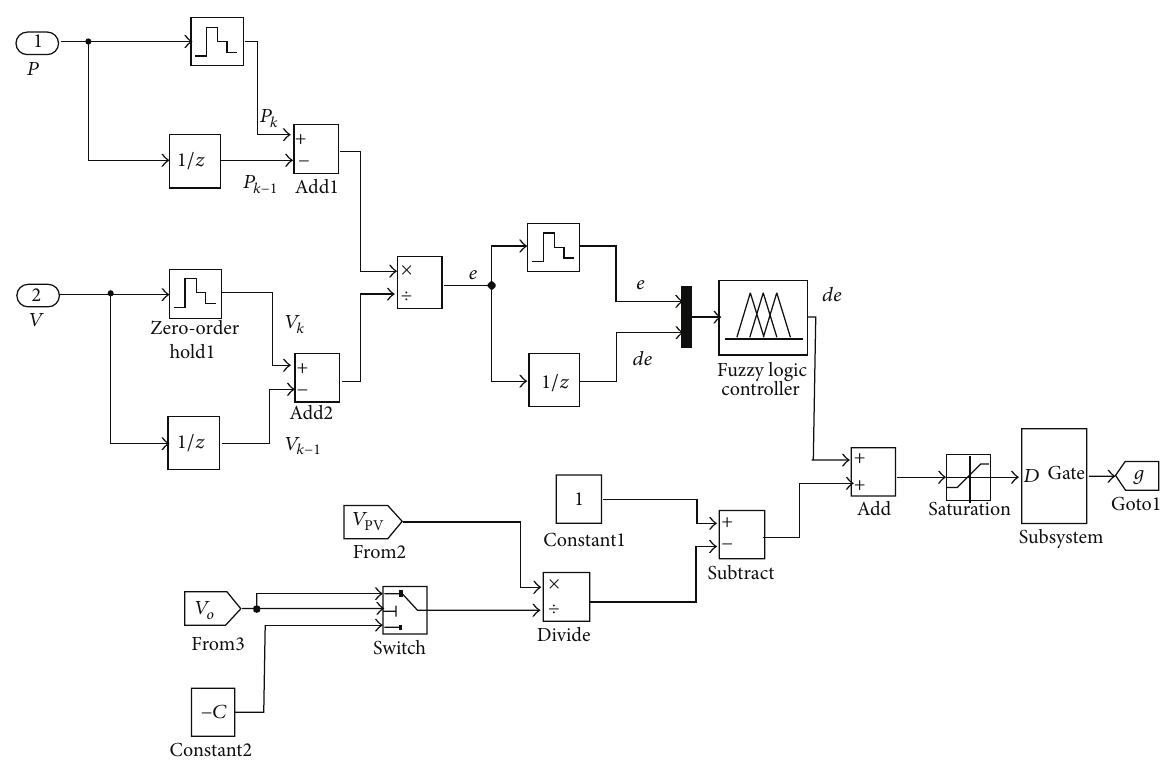
Figure 8: Fuzzy logic controller (FLC).